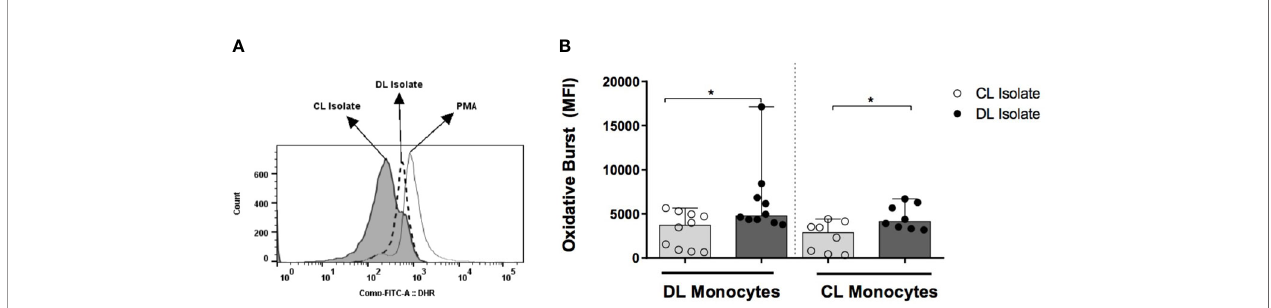
FIGURE 4 | Induction of oxidative burst by monocytes from patients with DL, CL or healthy subjects following infection with different L. braziliensis isolates: PBMC from patients with DL (n=12), CL (n=12) or HS (n=8) were treated with DHR (10ng/mL; 10 min) and infected with L. braziliensis isolates from DL or CL patients for 25 minutes at a ratio of 5:1 cells. PMA (1ug/ml) was used as positive control. Cells were stained with anti-CD14 for fl ow cytometric evaluation. (A) Representative gating strategy detailing CD14+ and DHR expression in monocytes from a CL patient. (B) Data representative as median of the mean fl uorescence intensity (MFI) of oxidative burst induction in DL and CL monocytes infected with different isolates. All p values were obtained using Wilcoxon ’ s signed-rank testing. Comparisons made between groups using Mann- Whitney statistical testing. (*p <